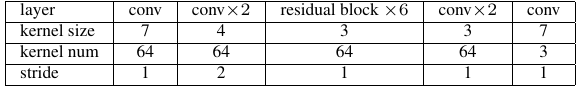
Table 3. Architecture of downsampling Generator G L .